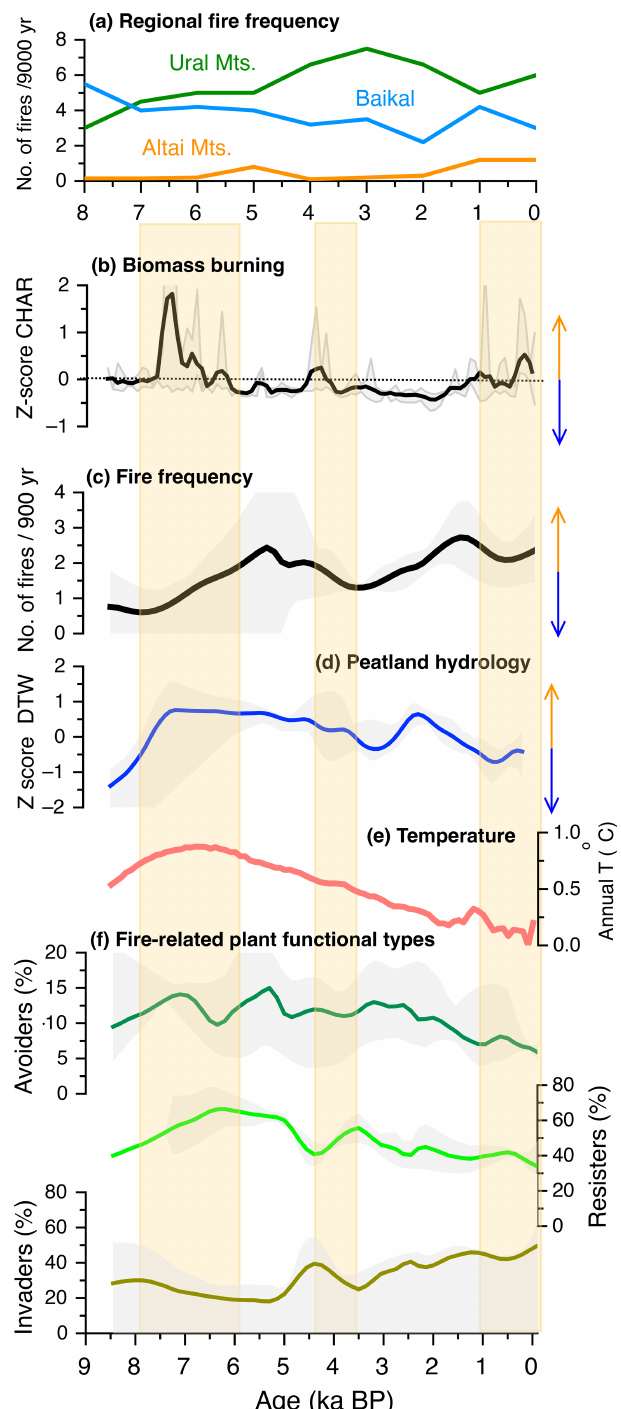
Figure 5. Charcoal-based fire frequency at locations in Pinus–Betula - dominated boreal forests in Russia: northern Ural region (Barhoumi et al., 2019), Lake Baikal (Barhoumi et al., 2021), and the western Siberian Plain (Rudaya et al., 2020) (a) . Composite record of biomass burning ( n = 4) based on Z -score charcoal influx; positive and negative Z -score values represent greater-than-mean and lower-than-mean charcoal influx over the base period (b) . Composite record of fire frequency ( n = 4) (c) . Composite record of peatland hydrology ( n = 4) from testate amoeba; positive and negative Z -score values represent lower- and higher-than-mean water level, respectively (d) . Annual temperature (anomalies) for 30–60 ◦ N (Kaufman et al., 2020) (e) . Composite record ( n = 4) of the relative abundance of avoiders, resisters, and invaders determined from pollen percentages (f) . Grey curves represent confidence intervals. Colours highlight the periods with higher biomass burning in the composite